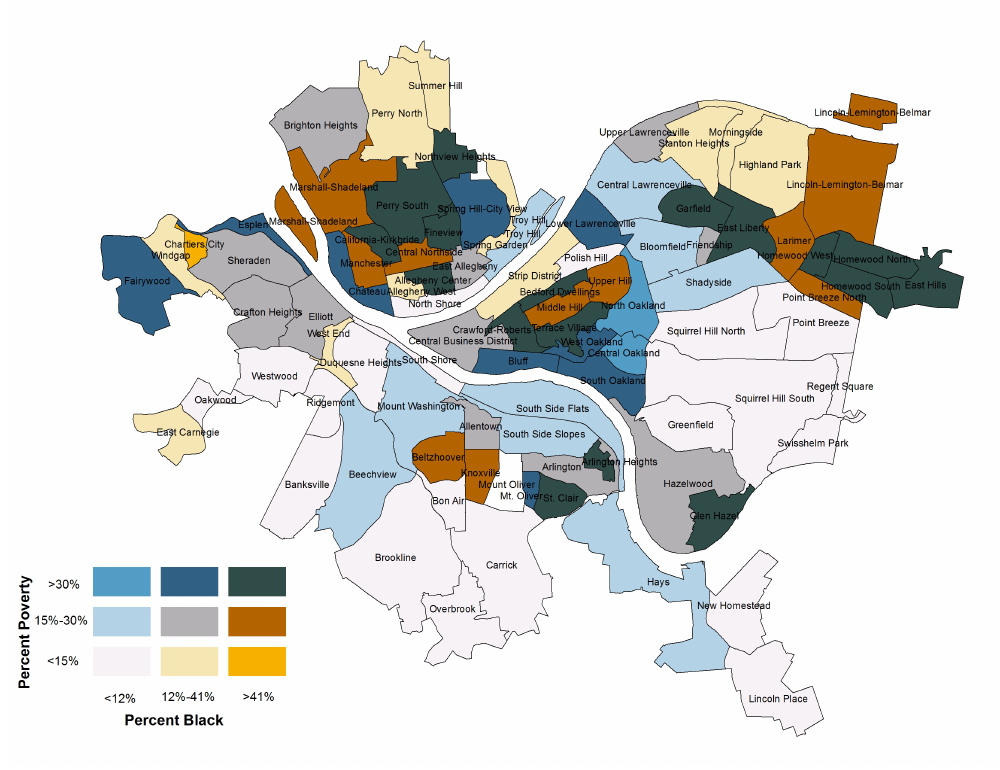
Figure 1. Map illustrating poverty and percent black across Pittsburgh